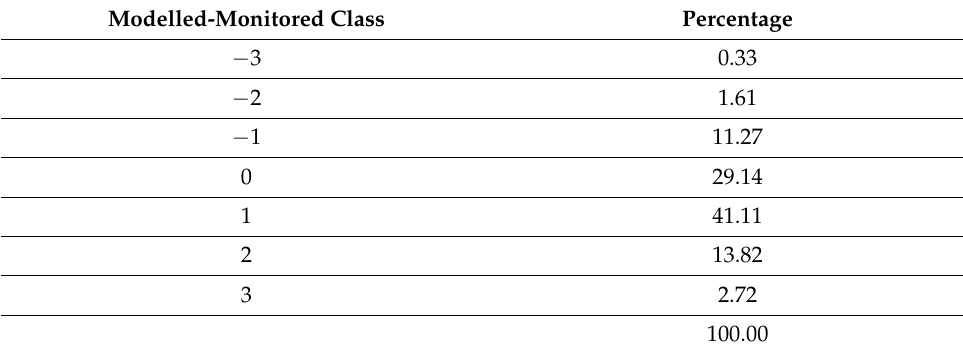
Table 2. Difference of vulnerability class between modelled and monitored